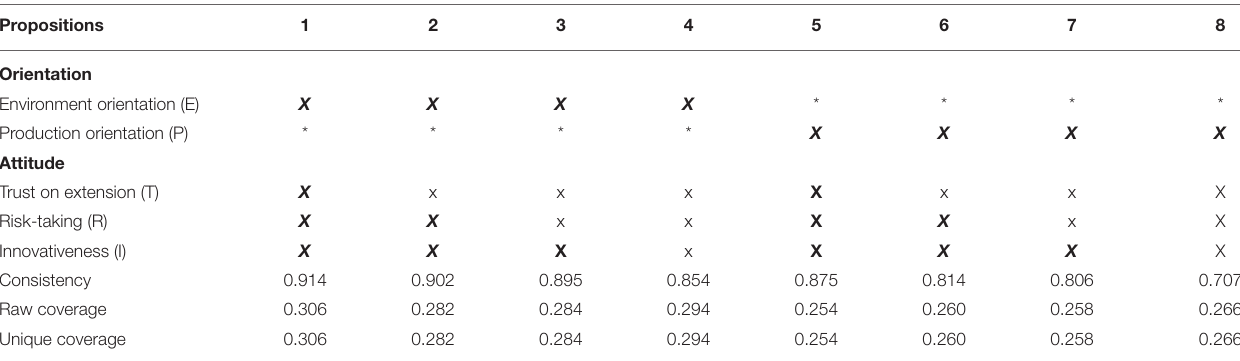
TABLE 5 | Configuration for study